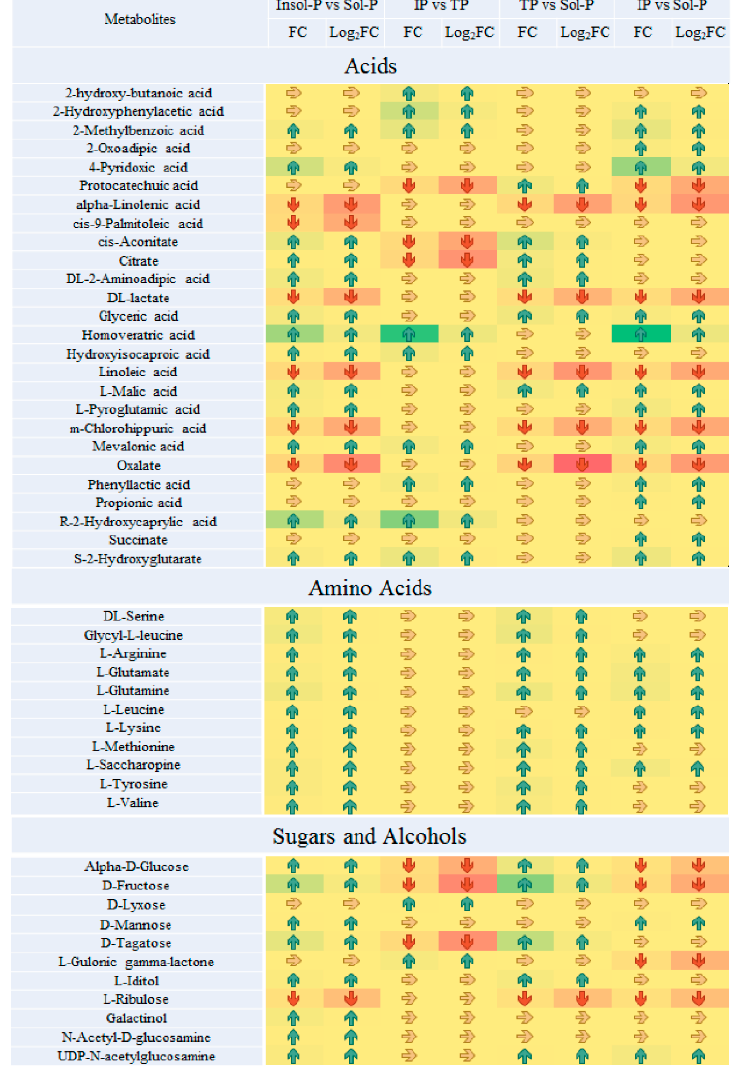
Figure 4. Continued. Figure 4.